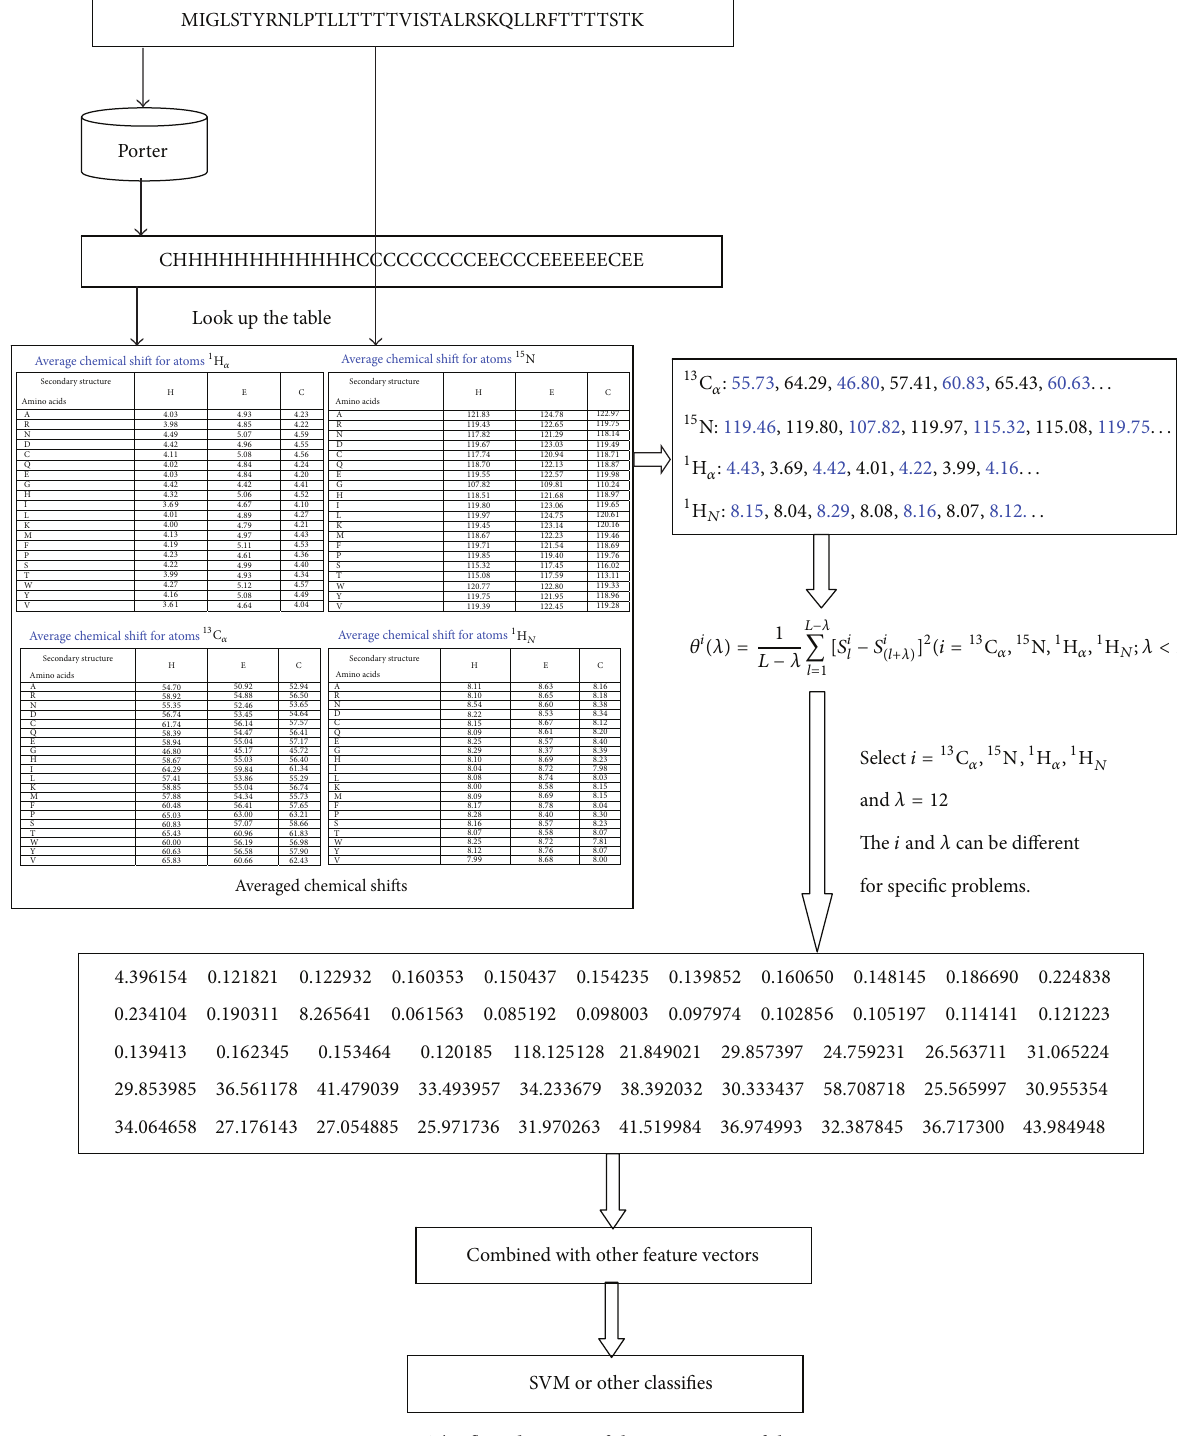
Figure 3: The flow diagram of the processing of the acACS. Table 3: The comparison of the results with and without the acACS for other kinds of proteins prediction. With acACS Without